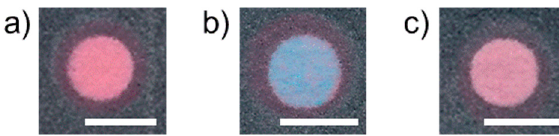
Figure 3. Effect of Cu 2+ masking by salicylaldoxime: scanned images of the filter paper detection area after addition of 1 mL of ( a ) pure water on device with reagent impregnated glass fiber layers, ( b ) 50 μ M aqueous CuCl 2 solution on device without glass fiber layers, ( c ) 50 μ M aqueous CuCl 2 solution on a device with impregnated glass fiber layers (scale bars: 4 mm).